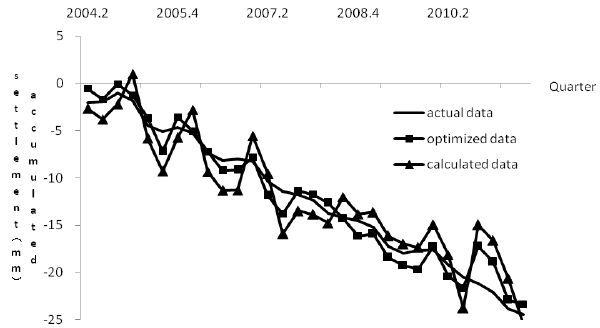
Figure 4. The calculated, actual and optimized value of F3–4.